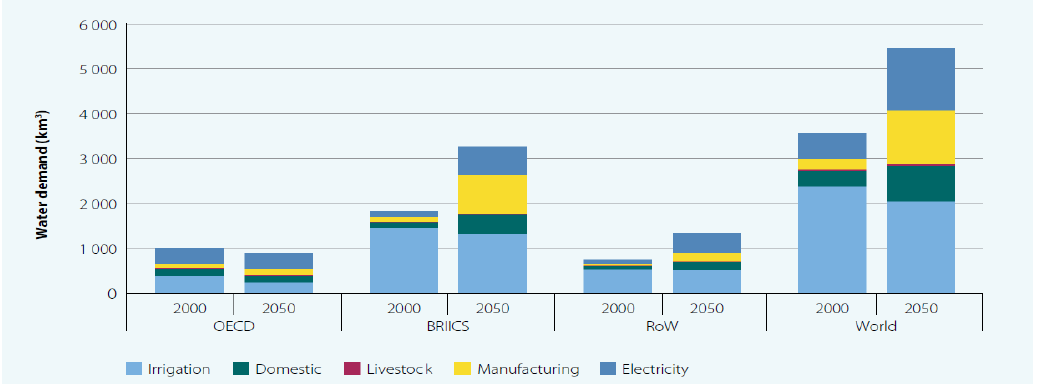
Figure 1. Levels of water stress by country (2000–2015) [7]. ( © 2018 International Water Management Institute (IWMI) and the Food and Agriculture Organization of the United Nations (FAO) Aquastat).